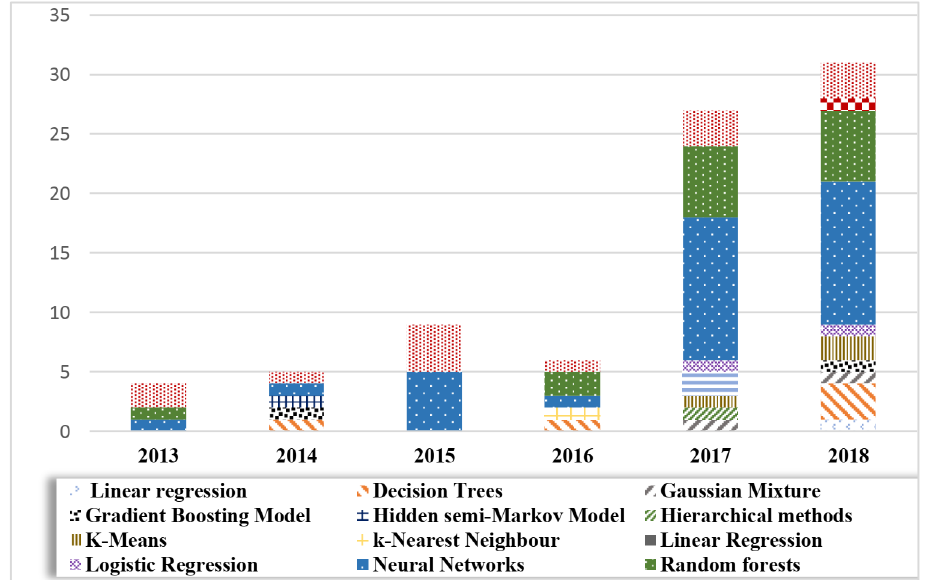
Figure 18. Popularity of machine learning methods by